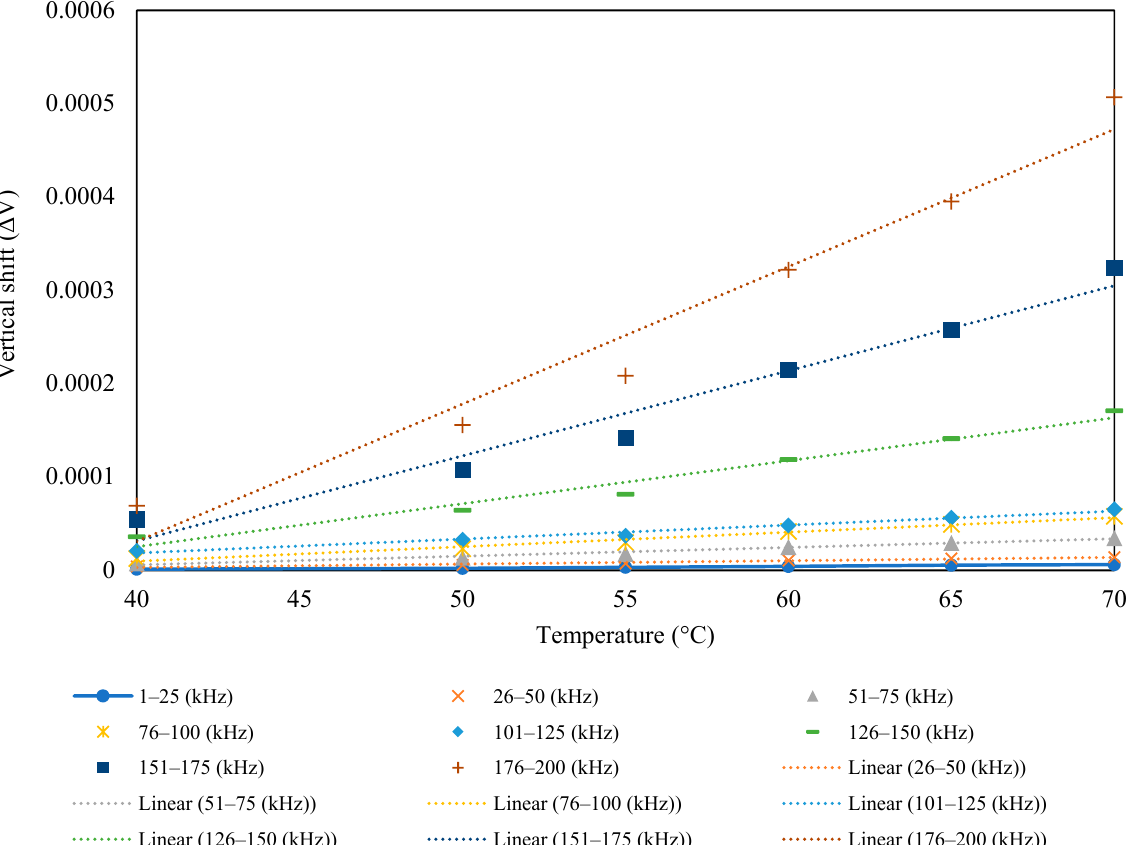
Figure 6. Vertical shift as a function of temperature.